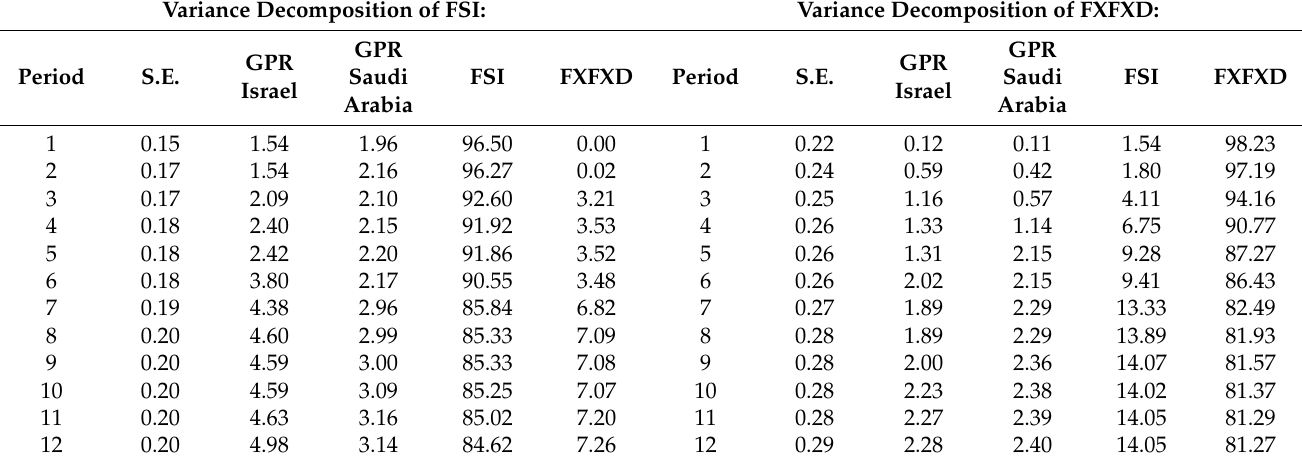
Table A2. Variance decomposition of FSI and